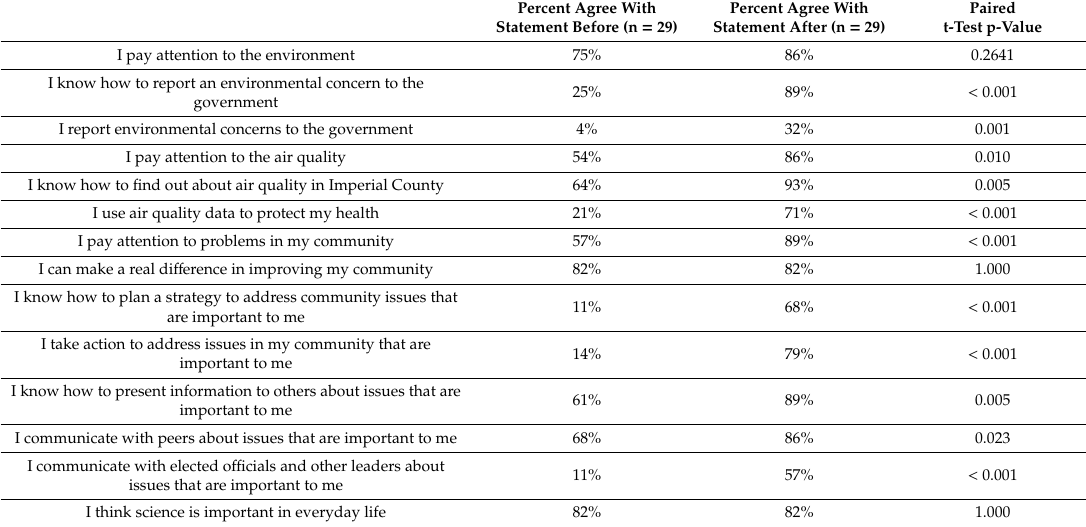
Table 2. Attitudes and behaviors of related to environmental health literacy and leadership before and after the youth environmental health internship.